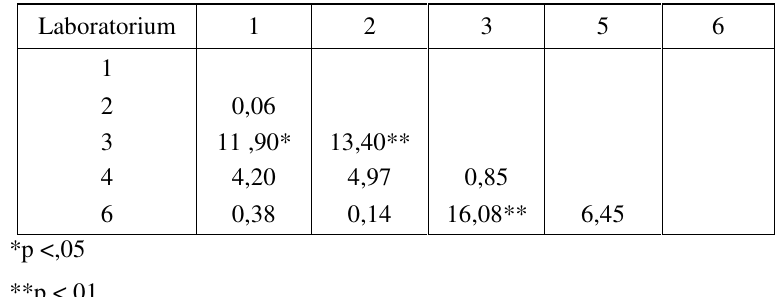
BEDUIDENDHEID VAN VERSKILLE TUSSEN LABORATORIUNS TEN OPSIGTE VAN DIE HOUDING TEENOOR WAARNEMING DEUR